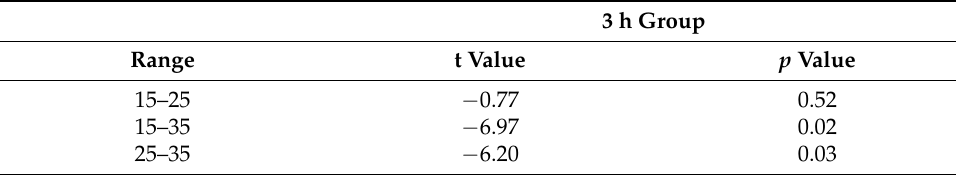
Table 8. Post hoc multiple comparisons (salinity).